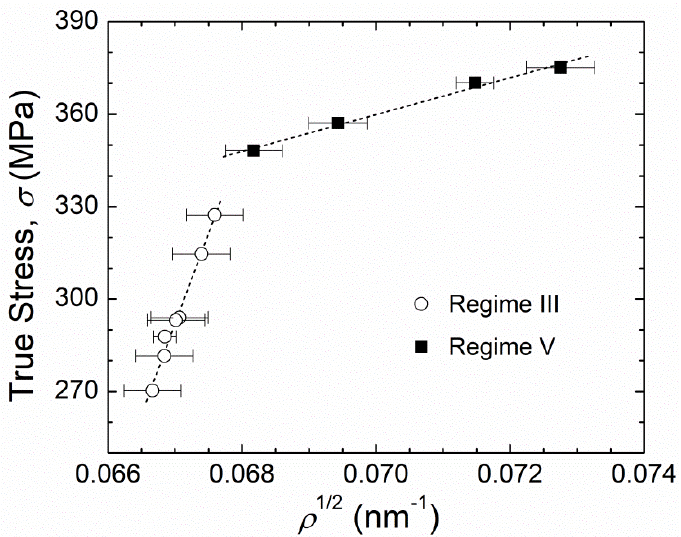
Figure 6. True applied stress, σ TS , vs. the square root of dislocation density, ρ 1 / 2 , for nc-Ag plastically deformed in Regimes III and V, respectively. Dashed straight lines represent linearly fitted data.